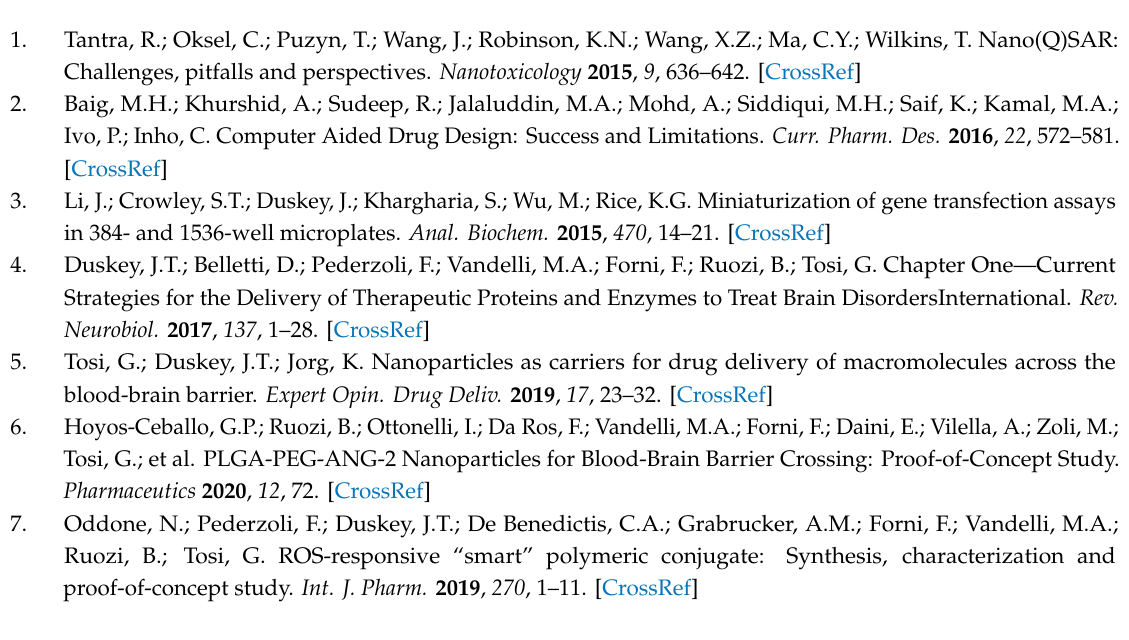
Figure S1: Full FTIR Scan of PLGA and chitosan polymers, Figure S2: 2D NMR correlation analysis of the 1H and 13C PLGA-chitosan reaction product, Figure S3: FTIR analysis of chitosan control (Red), chitosan-SDS salt (green) and SDS salt (blue), Figure S4: Solid state 13C NMR analysis with highlighted peaks of interest: chitosan (purple), SDS (red), TRIS salt (blue), Figure S5: Dynamic scanning calorimetry analysis: chitosan-SDS salt (black line), chitosan: PLGA 1:1.5 physical mixture (green